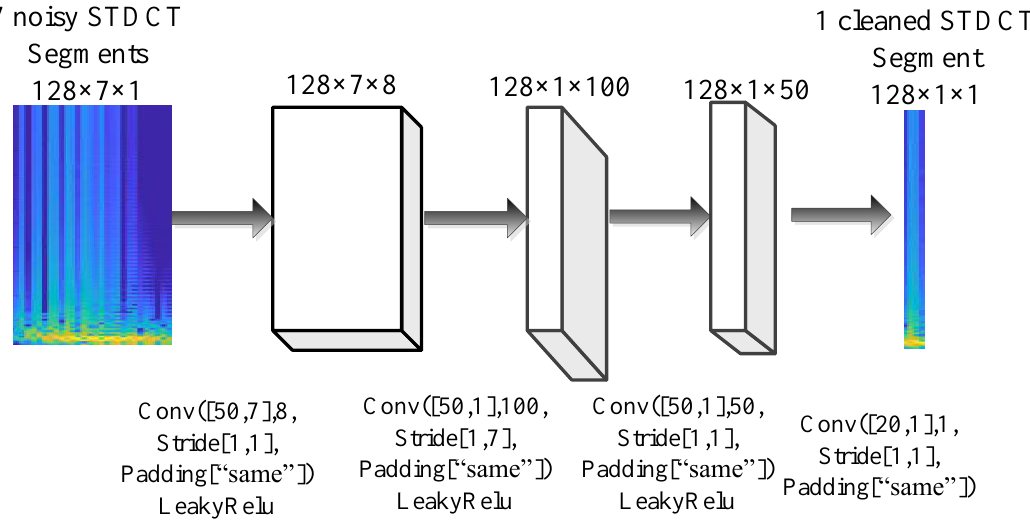
Figure 2. Deep convolutional neural network for SNR enhancement with convolutional (Conv) and LeakyRelu